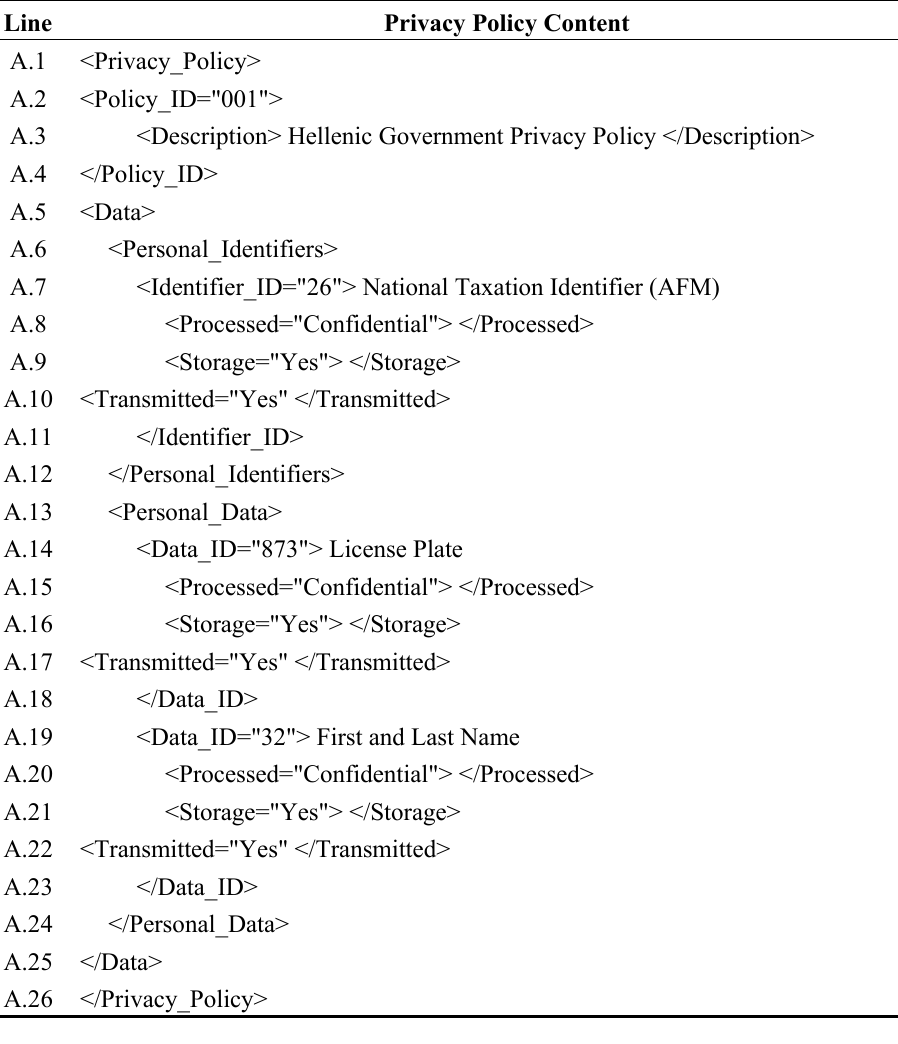
Table 1. Hellenic Government Privacy Policy.